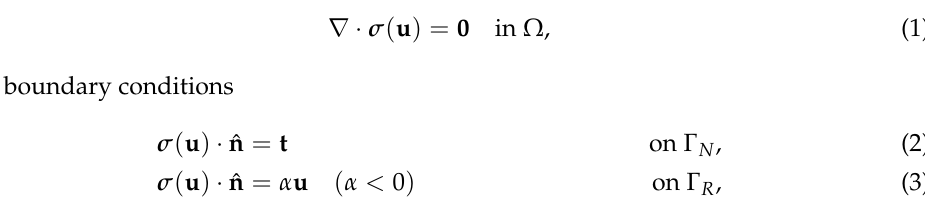
Figure 1. Schematic description of Problem (1) in the Euclidean space. In particular, Ω = (cid:83) 4 with ∂ Ω = Γ N ∪ Γ R where Γ N and Γ R are depicted in red and cyan,